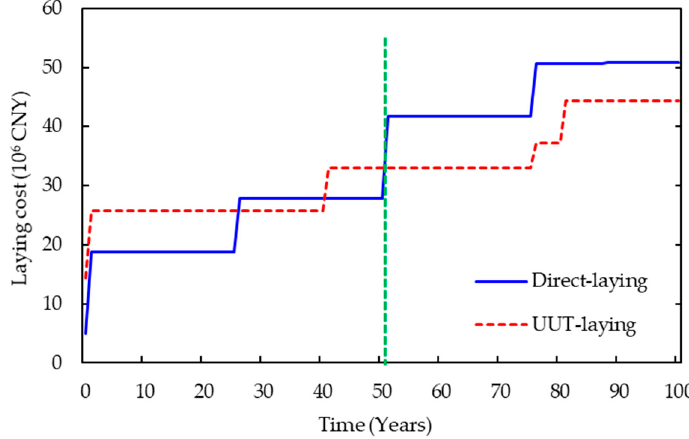
Figure 5. Comparison of power cable laying costs.